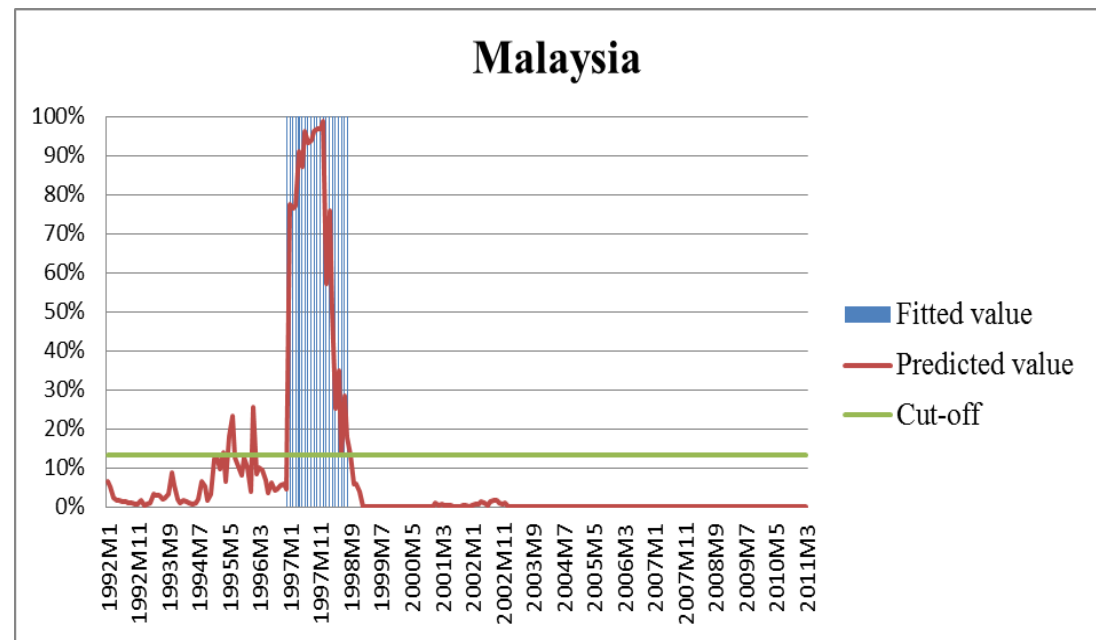
Figure 4. Actual and predicted value of five Asian emerging countries.